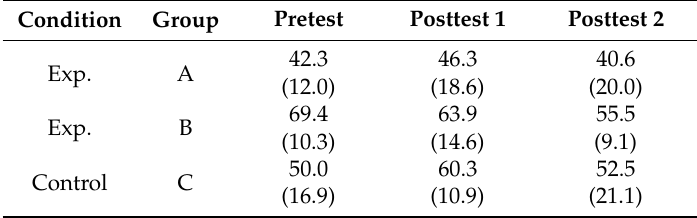
Table 2. Mean (and standard deviation) on the listening comprehension tests (in %).